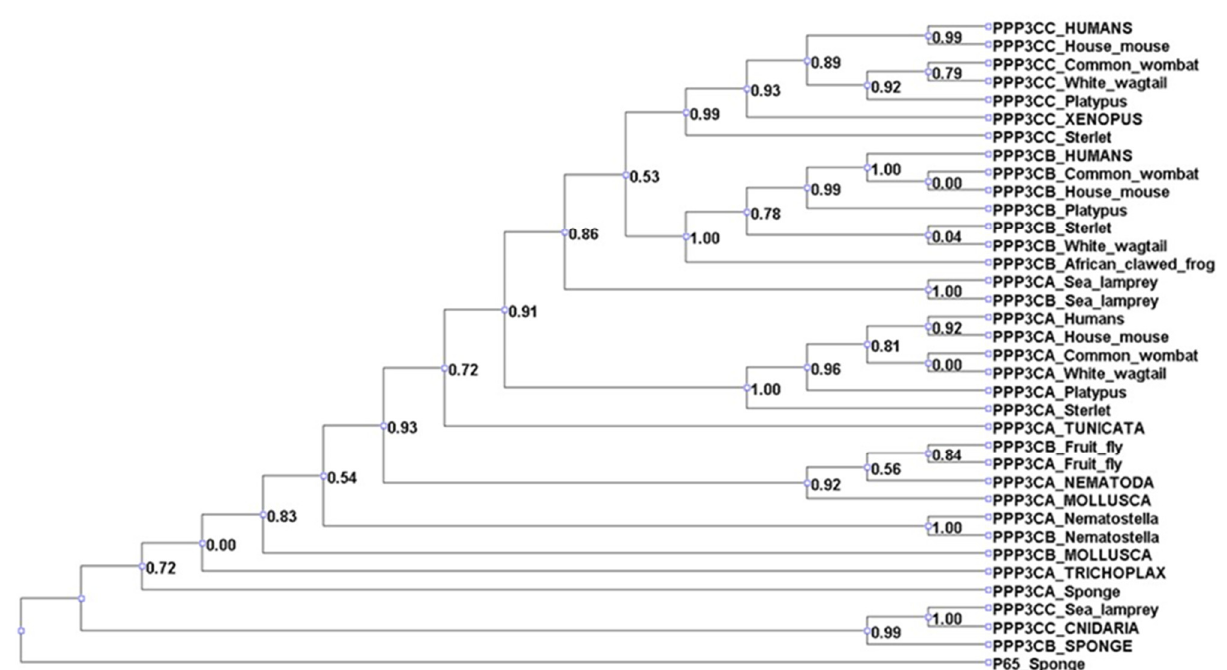
Figure 4. PPP phylogenetic analysis . Our analysis of the PPP family shows that it has an ancient history, as it first emerged during sponge divergence. Interestingly, Tregs inhibit the calcineurin pathway to halt the differentiation of conventional T cells.